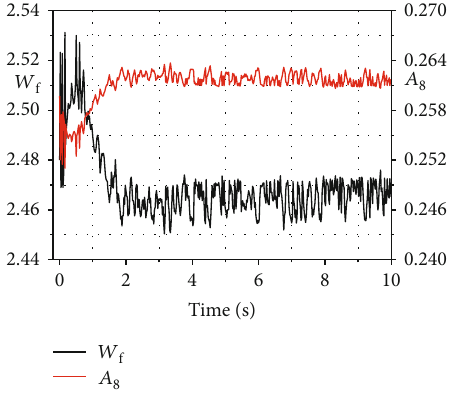
Figure 16: Histories of control inputs W